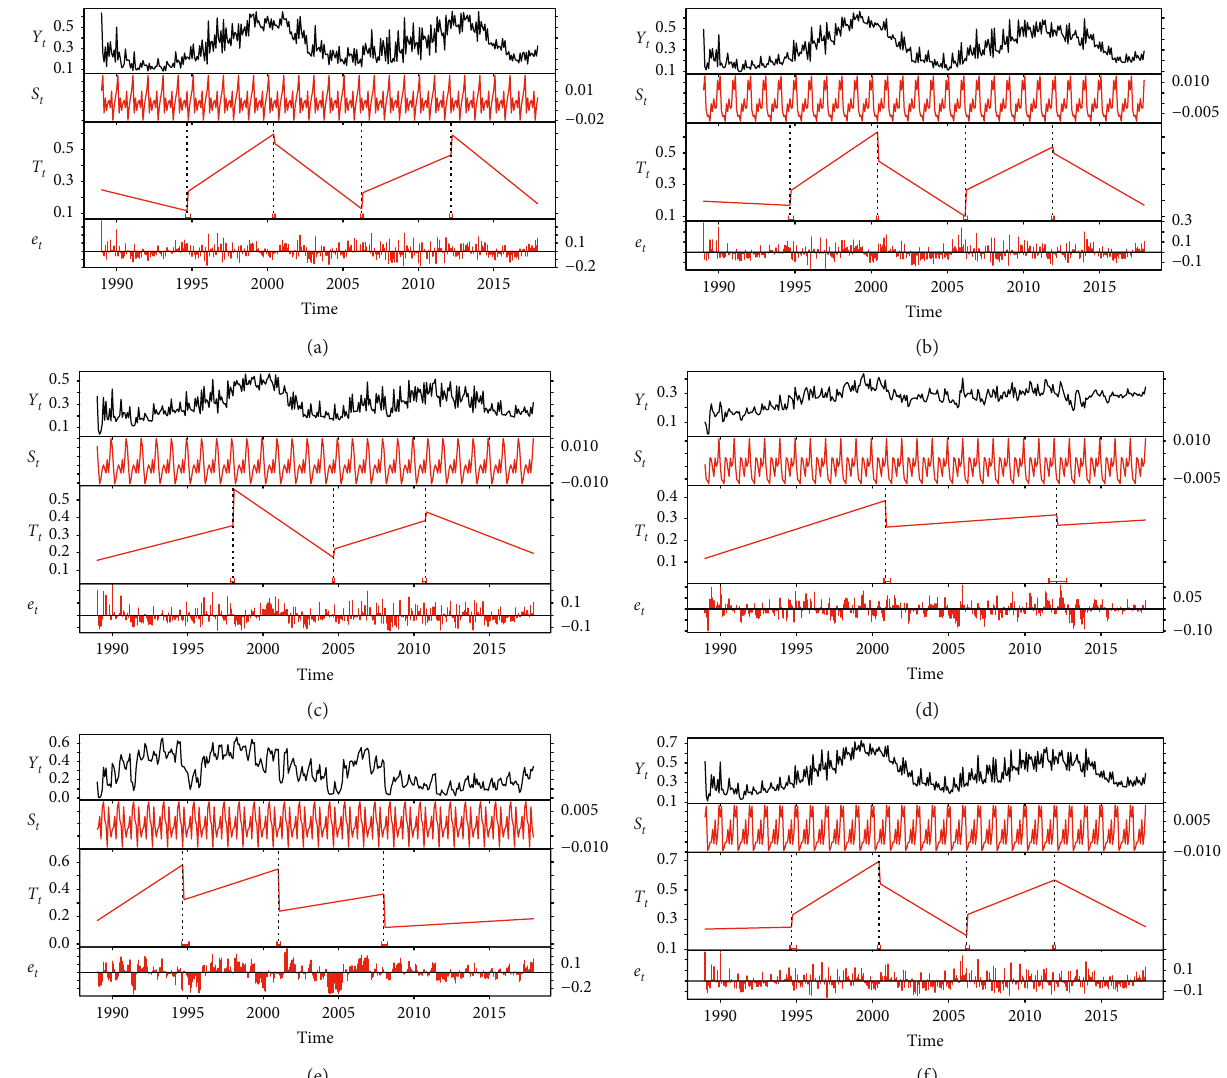
Figure 6: Trends of monthly average area percentage of the subregions in the Belt and Road area. (a) Equatorial. (b) Arid. (c) Warm. (d) Snow. (e) Polar. (f) Entire study